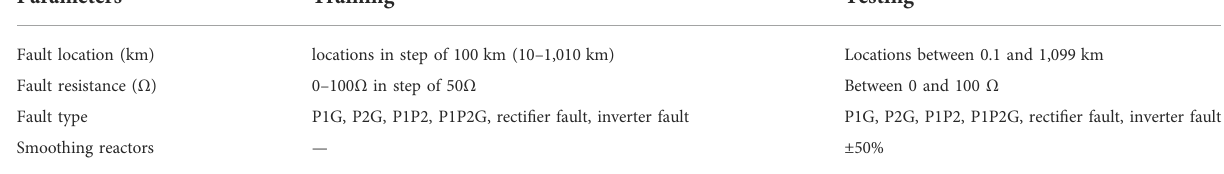
TABLE 1 Change of fault parameters.